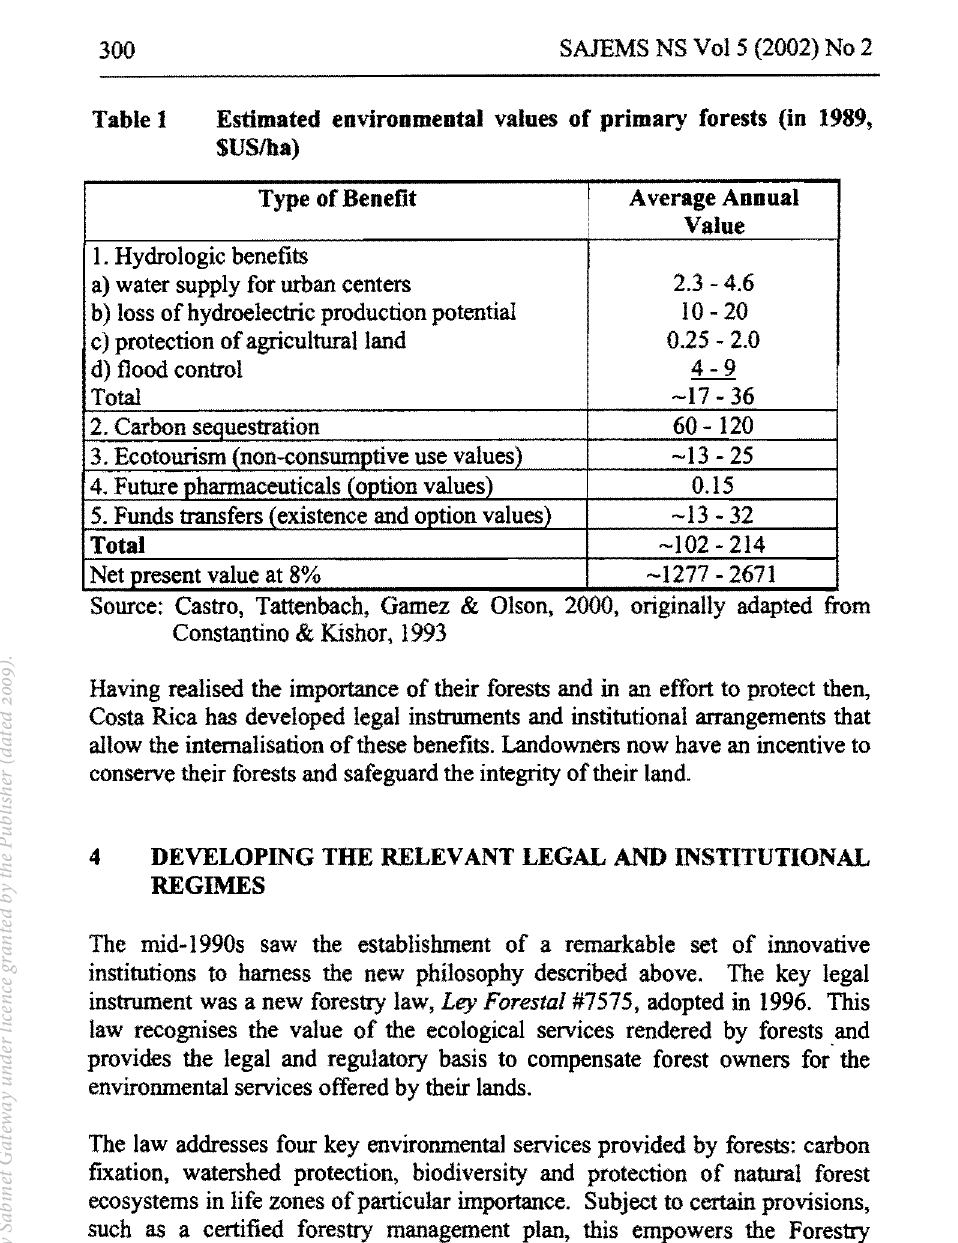
Estimated environmental values of primary forests (in 1989, SUSlba) Type of